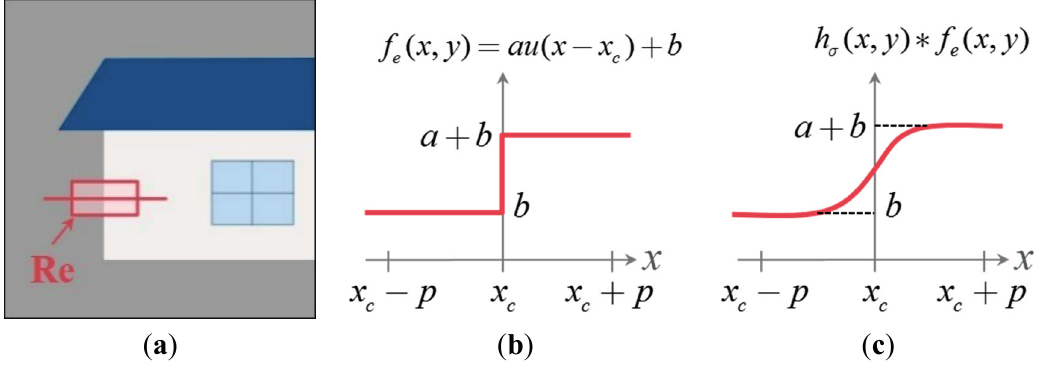
x y , denoted as R , containing c c e R ; and ( c ) the e